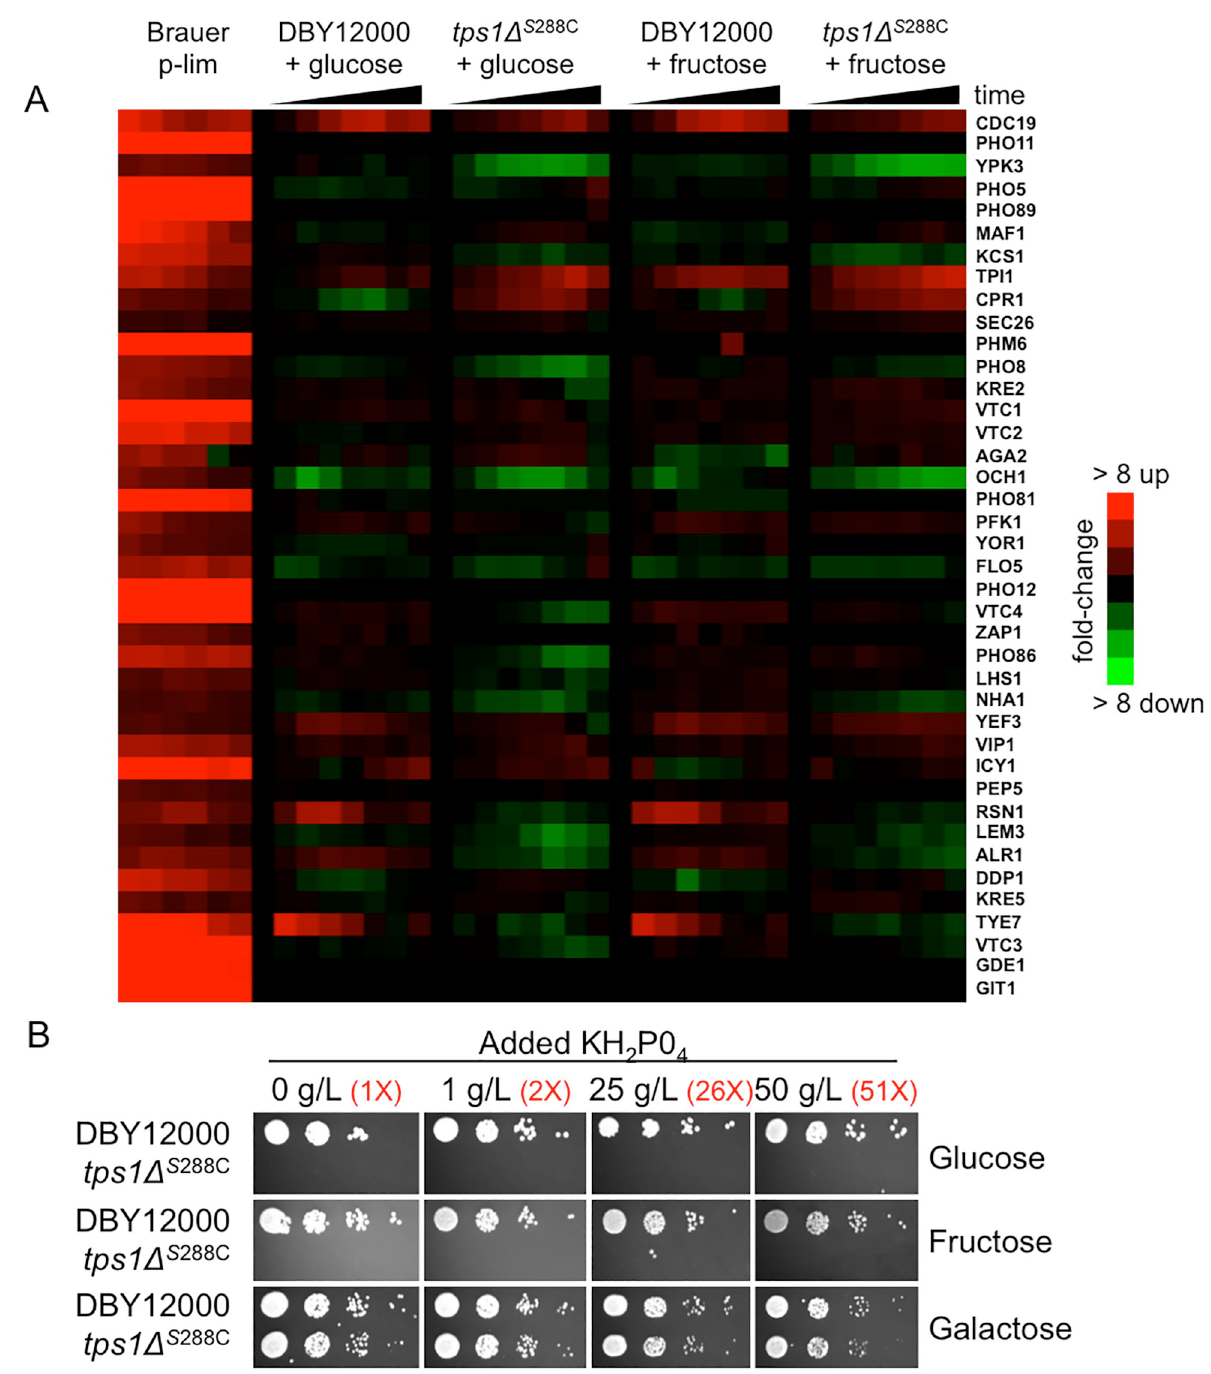
Fig 3. The tps1 Δ persister-like state is not regulated by intracellular phosphate depletion. (A) Phosphate-responsive gene expression response of wild type (DBY12000) and tps1 Δ cells grown to mid-log phase in YNB + 2% galactose before being treated with glucose or fructose (to 2%) as indicated (each column represents a time-course point: 0, 2.5, 5, 10, 15, 30, 60, and 120 minutes). Cells were collected for RNA extraction and RNA- seq analysis as described in Materials and Methods. Shown on the left for comparison are the data for genes activated by phosphate limitation from Brauer et al . (data is ordered as in Brauer et al ., where gene expression from left-to-right corresponds to changing steady-state growth rates from slow to fast: 0.05, 0.1, 0.15, 0.2, 0.25, 0.3 per hour)[33]. (B) The indicated strains were grown overnight in YNB + 2% galactose liquid before 10-fold serial dilutions were prepared and spotted onto the indicated media. Phosphate was added at the indicated concentrations, with fold-change comparison to standard minimal media indicated in red. Listed carbon sources were present at 2%. The initial dilution had an OD 600 of 0.1. Plates were incubated at 30˚C for 3 days. Strains used in this figure: DBY12000, DBY12383.